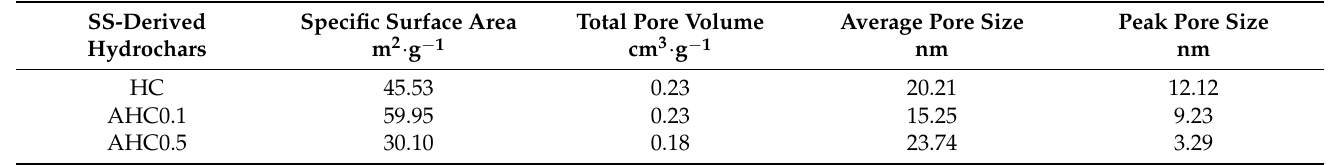
Table 4. Pore characteristics of SS-derived